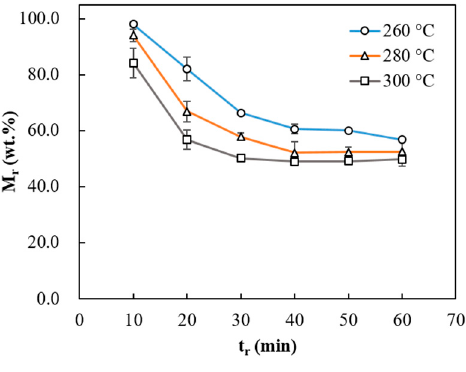
Figure 2. Torrefaction curves of M r for JMS in various torrefaction conditions using a muffle